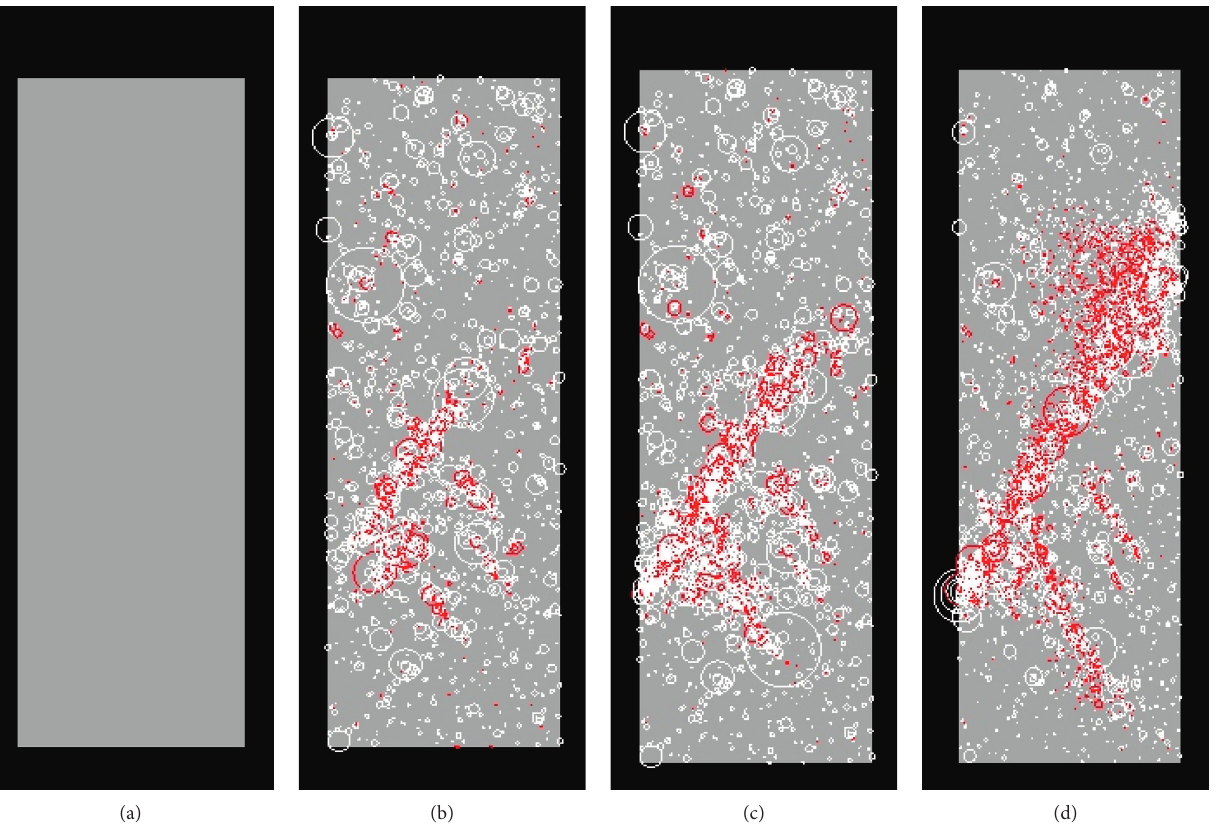
Figure 15: Acoustic emission propagation process of rock mass at ratio of height to diameter of